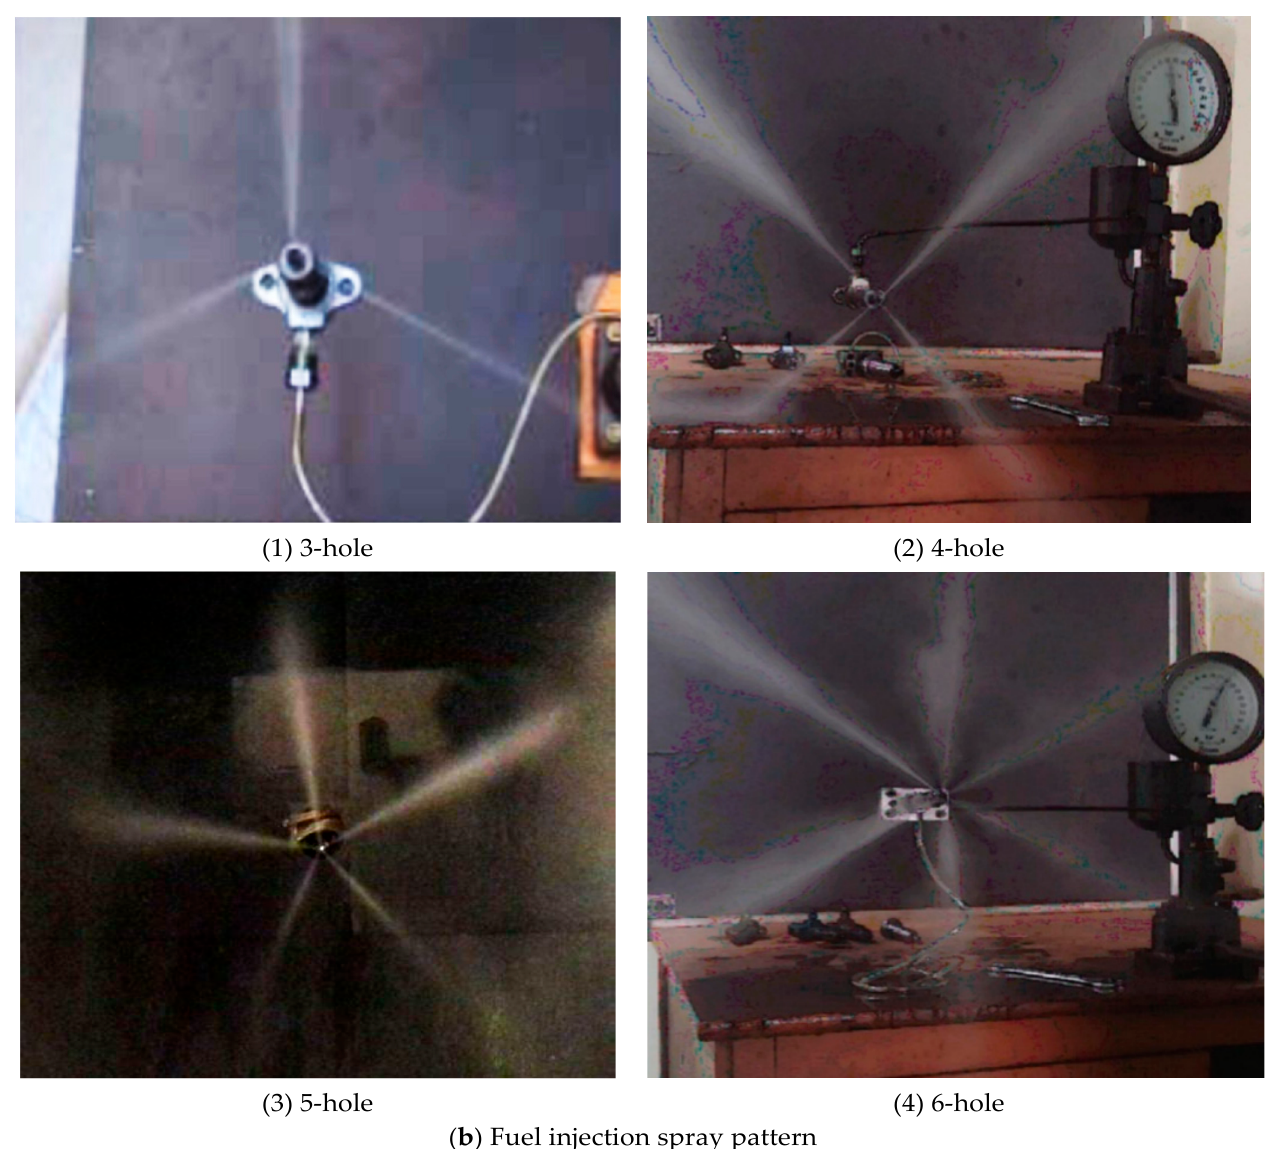
Figure 2. Engine ( a ) Experimental setup Reproduced from [6] Elsevier: 2019 and ( b ) fuel injection spray pattern Reproduced from [56] Elsevier: 2019.